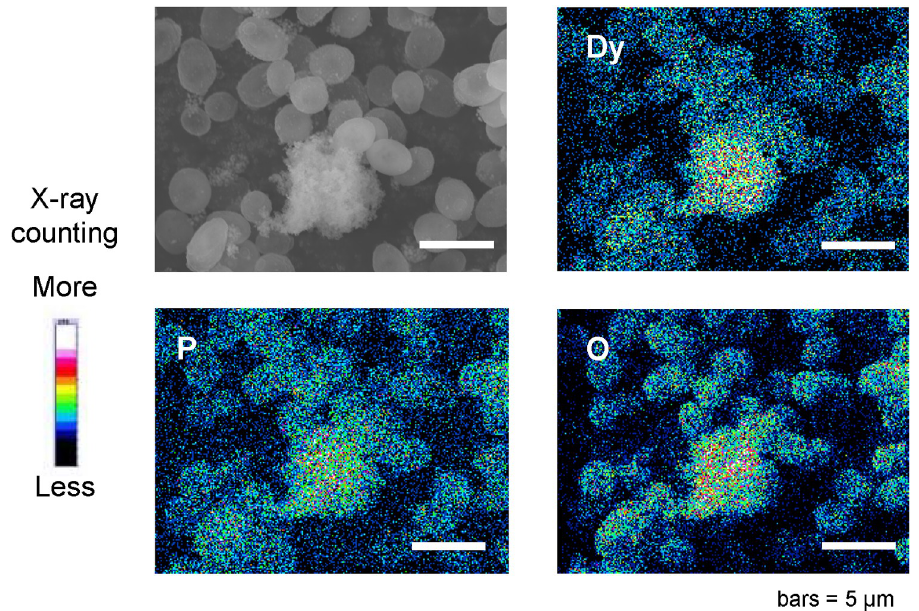
Fig 5. SEM image and two-dimensional localization of dysprosium, phosphorus, and oxygen on phosphorylated yeast cells, analyzed using FESEM-EDS. Yeast cell samples were collected on Day 6 of Dy 3+